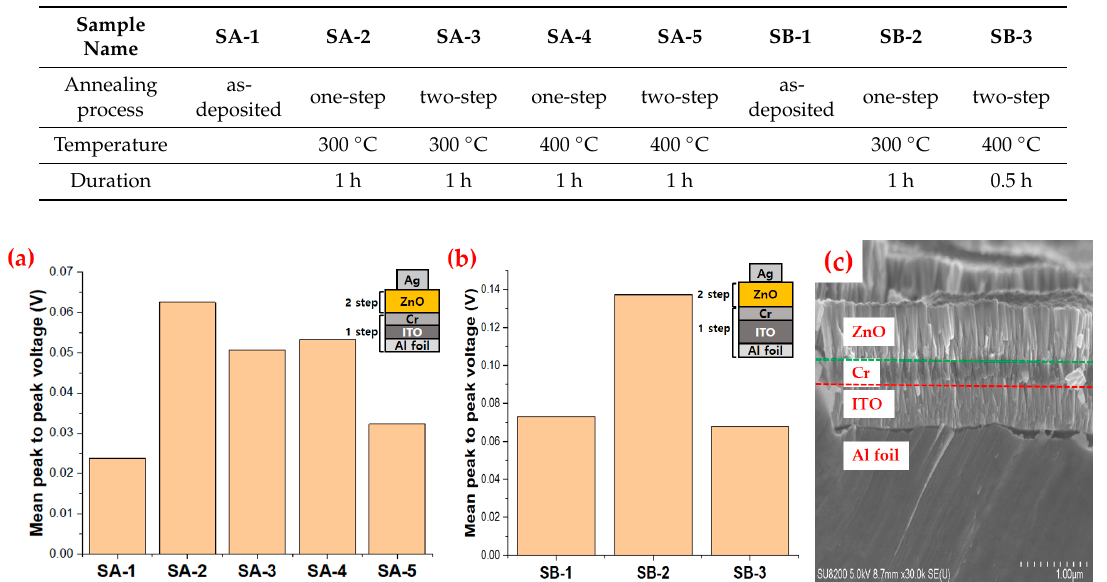
Figure 6. The eight devices were formed on the Al-foil substrates. Each device was annealed under different conditions, as specified in Table 2. ( a ) The five samples of the Ag/ZnO/Cr/ITO structure (SA-1 to SA-5) were formed on Al-foil substrates with an ITO layer thickness of 446 nm. ( b ) The other three samples (SB-1 to SB-3) were formed on the same Al-foil substrates with an ITO layer thickness of 1390 nm. ( c ) A representative SEM cross-section image of the sample SA-1 (scale bar 1 μ m).